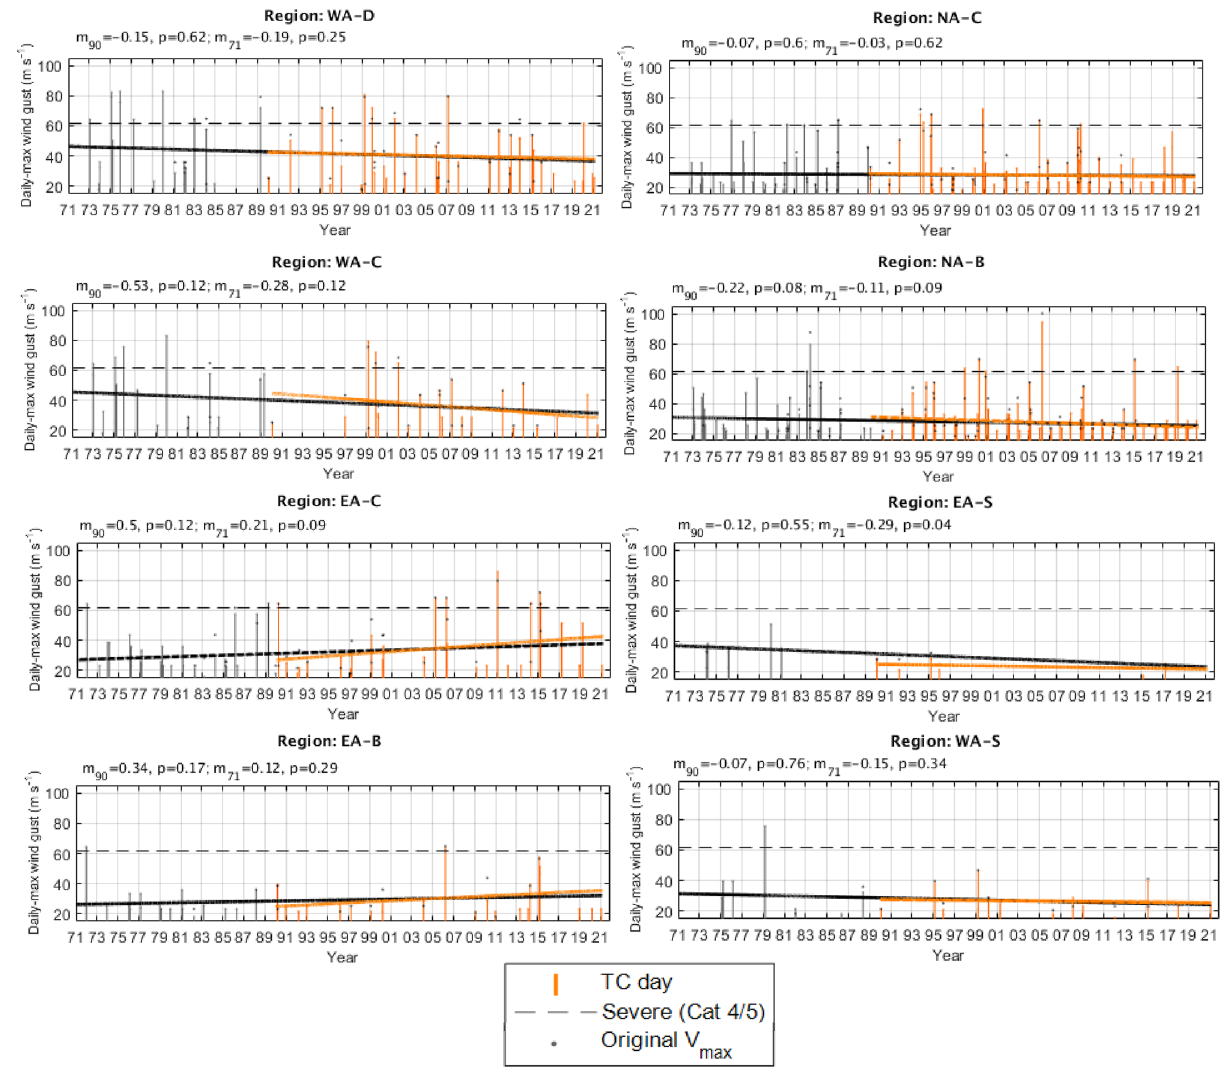
Figure 5. As in Fig. 3 but for best track TC wind gust speeds [replaced with adjusted V max over the period 1981–2016 (Courtney and Burton